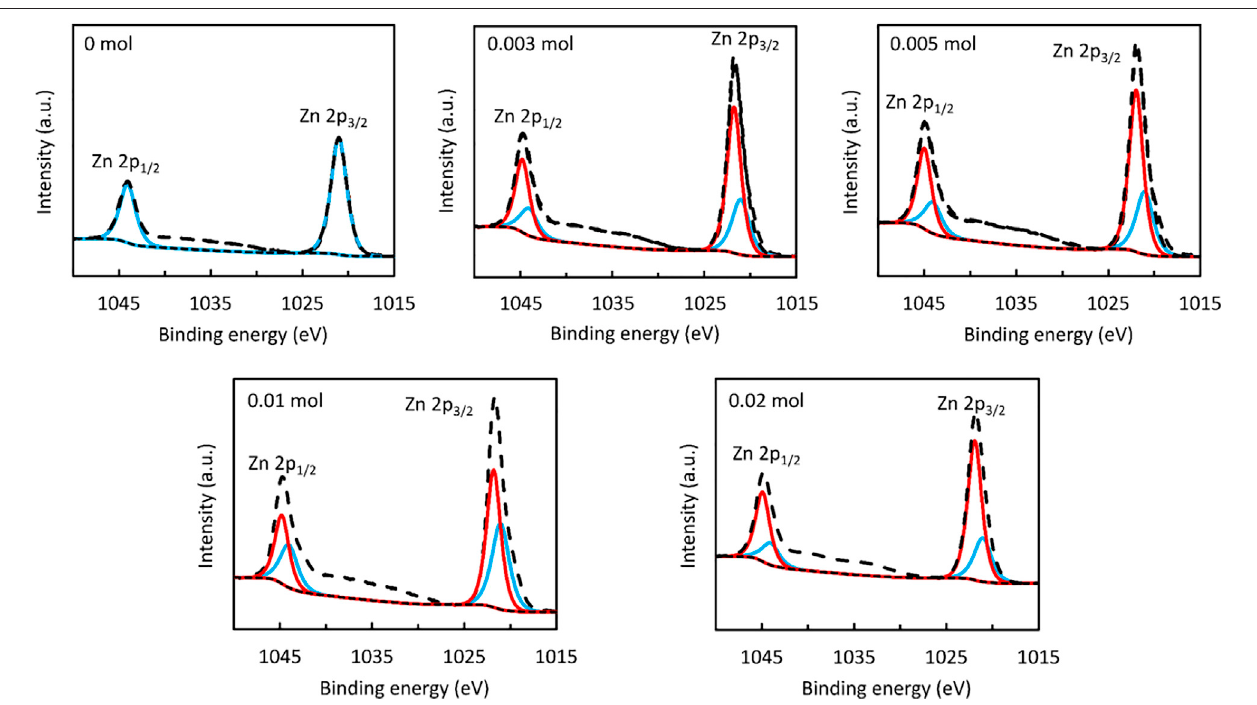
FIGURE 3 | Zn (2p 3 ) XPS spectrum of ZnS nanostructures prepared using different amounts of NaBH 4 .